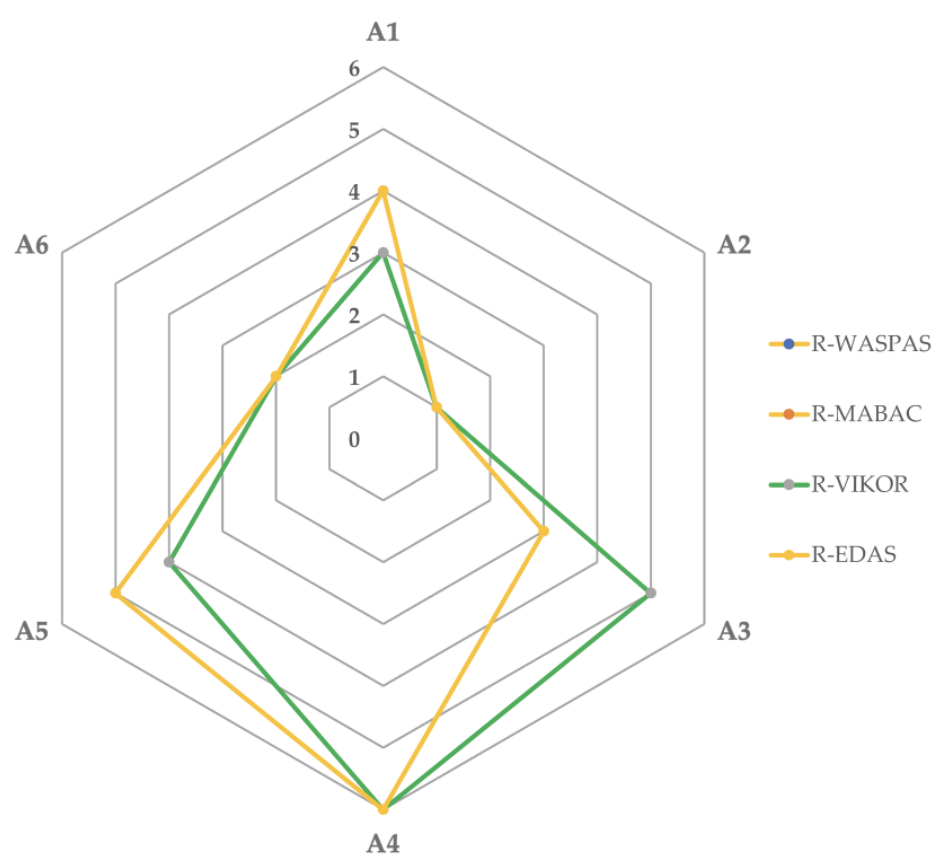
Figure 5. Comparative analysis of proposed approach with other rough MCDM methods.